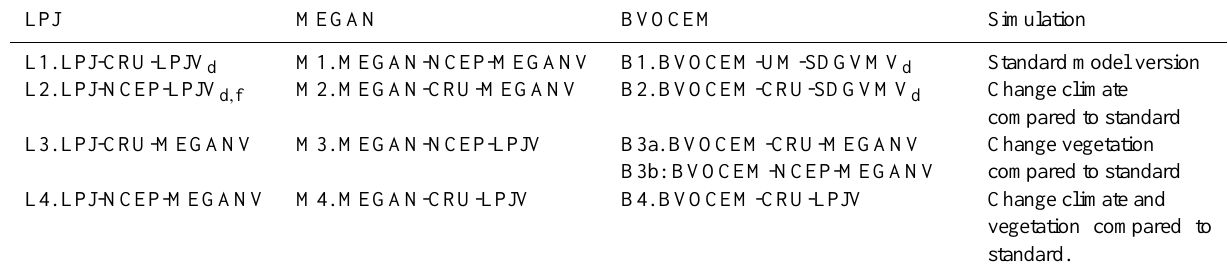
Table 1. List of simulations, described as “Model-climate-vegetation” (for example, MEGAN-CRU-LPJV is MEGAN model, run with CRU climate data and LPJ vegetation (and emission factors) and MEGAN algorithm) and MEGAN algorithm. Subscripts “d” and “f” indicate whether the DGVMs had dynamic vegetation enabled, or were driven by fixed vegetation